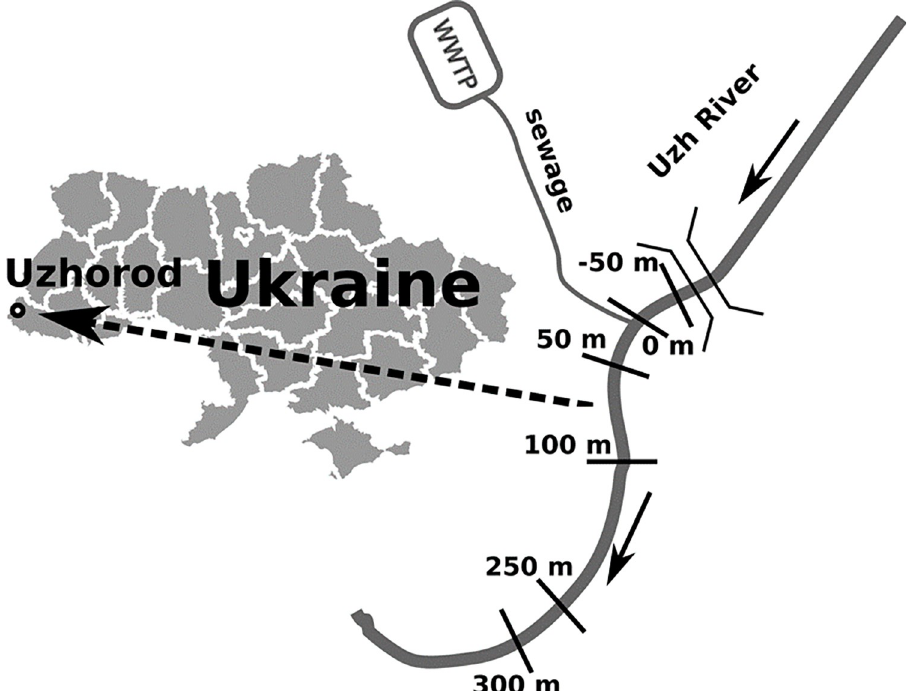
Fig 1. Location of the study area and sampling stations. The arrows along the river show the direction of the current. The dashed arrow indicates the location of the study area on the map. Republished from [40] under a CC BY license, with permission from [SimpleMaps.com Pareto Software, LLC], original copyright